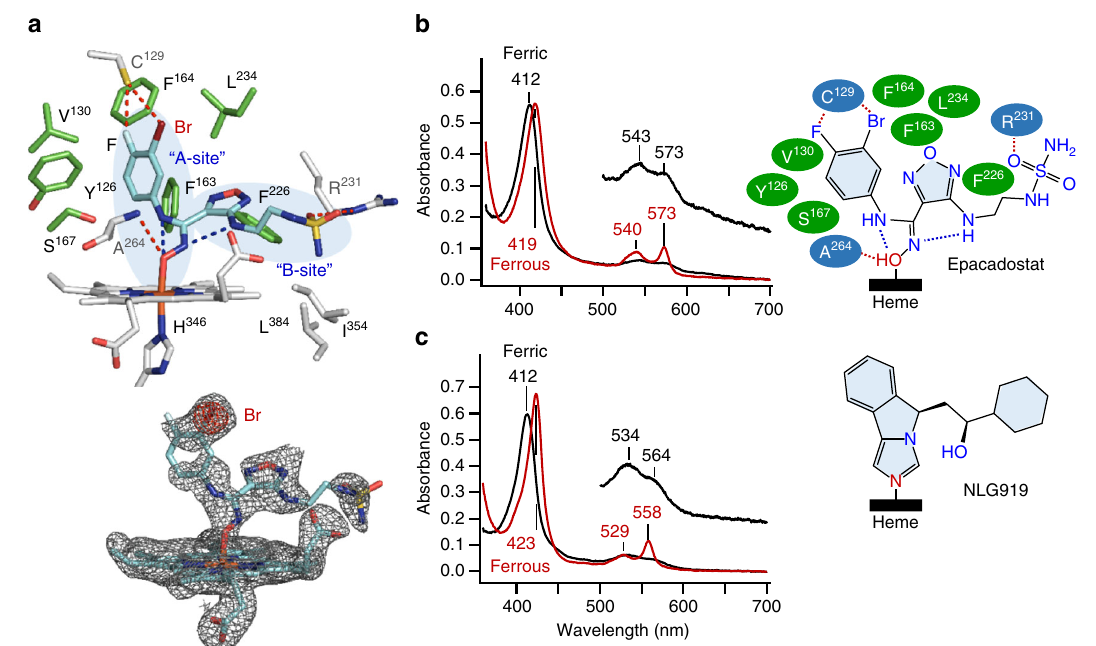
Fig. 2 Binding mode of epacadostat and spectral markers for O and N-based inhibitors. a Crystal structure of the hIDO1-epacadostat complex. The interactions between epacadostat and the protein matrix are indicated by the red dotted lines, while the intramolecular H-bonds within epacadostat are indicated by the blue dotted lines. The bottom inset shows the 2Fo-Fc map of the epacadostat and the heme, contoured at 1.0 σ (colored in gray). It is overlaid with the anomalous difference Fourier map contoured at 9.0 σ (shown in red), con fi rming the position of the Br atom. b , c Optical absorption spectra of hIDO1 in complex with epacadostat or NLG919, which coordinates to the heme iron via its oxygen or nitrogen atom, respectively, in the ferric state (black trace) and ferrous state (red trace). The right inset in b shows a schematic illustration of the epacadostat – protein interactions. It should be noted that the bound epacadostat is displayed as a protonated form, but its true protonation state requires additional